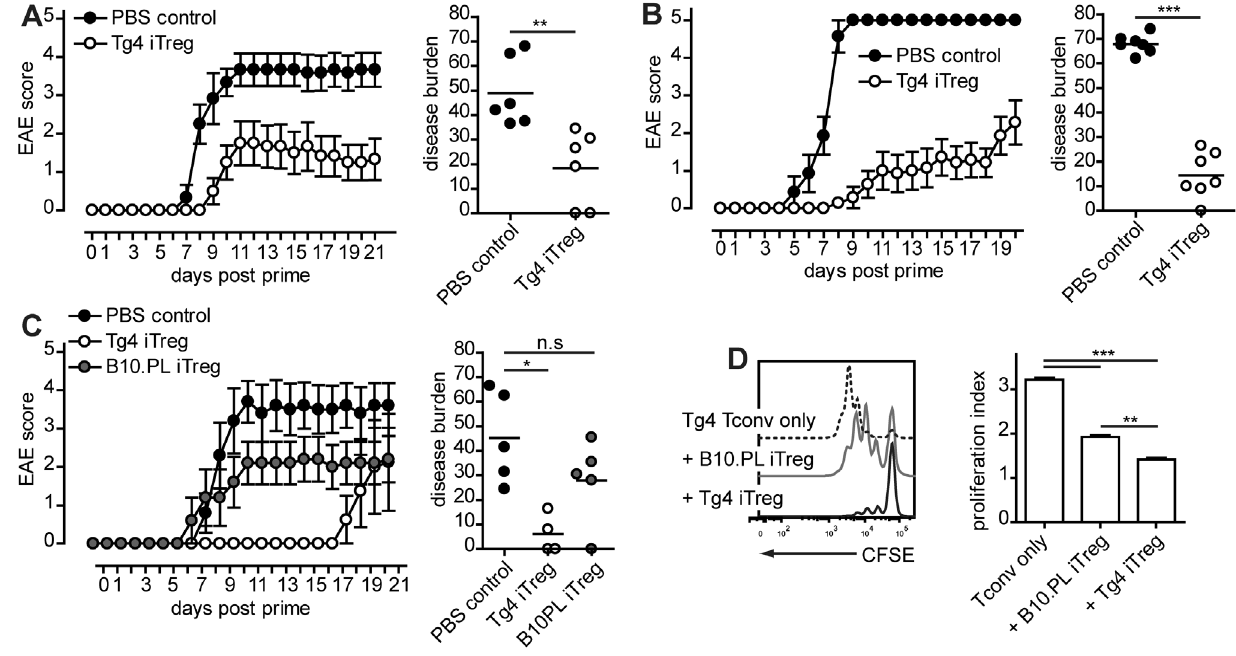
Figure 1. Antigen-specific iTreg cells ameliorate EAE progression. A–C. Mice received 5 6 10 6 iTreg cells in PBS or PBS only i.p. 2–3 days prior to EAE induction with MBP Ac1–9 in CFA. A. Tg4 Rag + / + recipients. N=6 per group, combined from 2 individual experiments. ** P=0.0022, Mann Whitney test. B. Tg4 Rag 2 / 2 recipients. n=7 per group, combined from 3 individual experiments. *** P=0.0006, Mann Whitney test. C. Tg4 Rag 2 / 2 recipients. PBS control and B10.PL iTreg n=5, Tg4 iTreg n=4, combined from 2 individual experiments. * P , 0.05, Kruskal Wallis with Dunn’s post- test. A-C EAE plots depict mean 6 SEM. Horizontal lines in disease burden scatter plots indicate mean. D. Tg4 CD45.1 naive CD4 + T cells, labeled with CFSE, were cultured alone or co-cultured at a 1 to 1 ratio with B10.PL or Tg4 (both CD45.2 + ) iTreg cells for 4 days and stimulated with 1 m g/ml